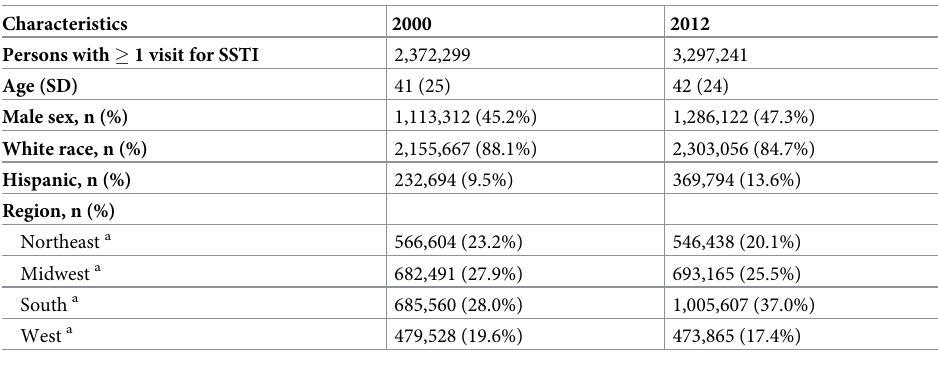
Table 1. Characteristics of persons with SSTIs in the U.S., 2000 and